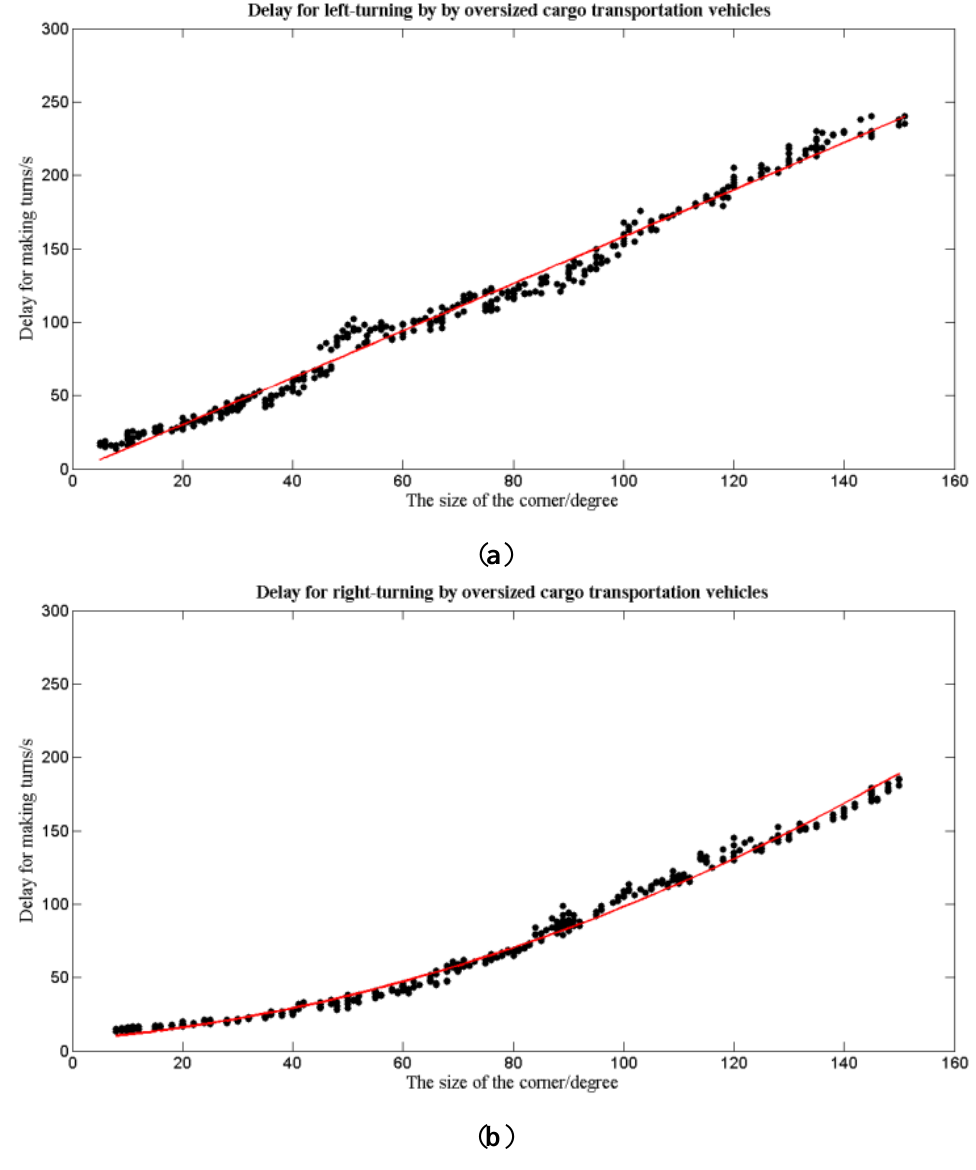
Figure 6. Fitting result of turning delay at road intersections: ( a ) delay of oversized trucks when making left turns at intersections; and ( b ) delay of oversized trucks when making right turns at